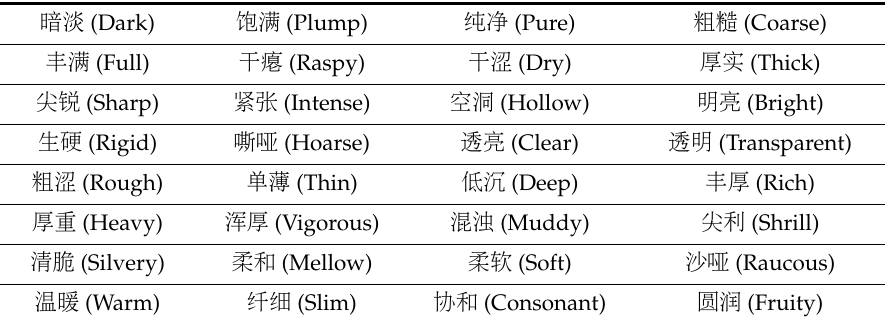
Table 2. Alexiconof32timbreevaluationtermsintheiroriginallanguage(Chinese), withanaccompanying English translation.